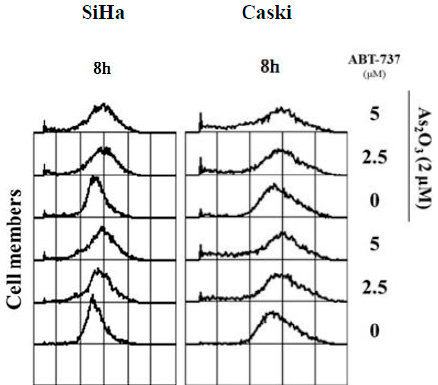
Figure 4. Effects of ABT-737 combined with As 2 O 3 on reactive oxygen species (ROS) production in cervical cancer cells. SiHa cells (4 × 10 5 cells / 6 cm dish) and Caski (4 × 10 5 cells / 6 cm dish) were co-treated with ABT-737 and As 2 O 3 for 8 h. After treatment, the cells were stained with 2 ′ ,7 ′ -dichlorodihydrofluorescein diacetate (H2DCFDA) dye to detect the production of ROS by flow cytometry.